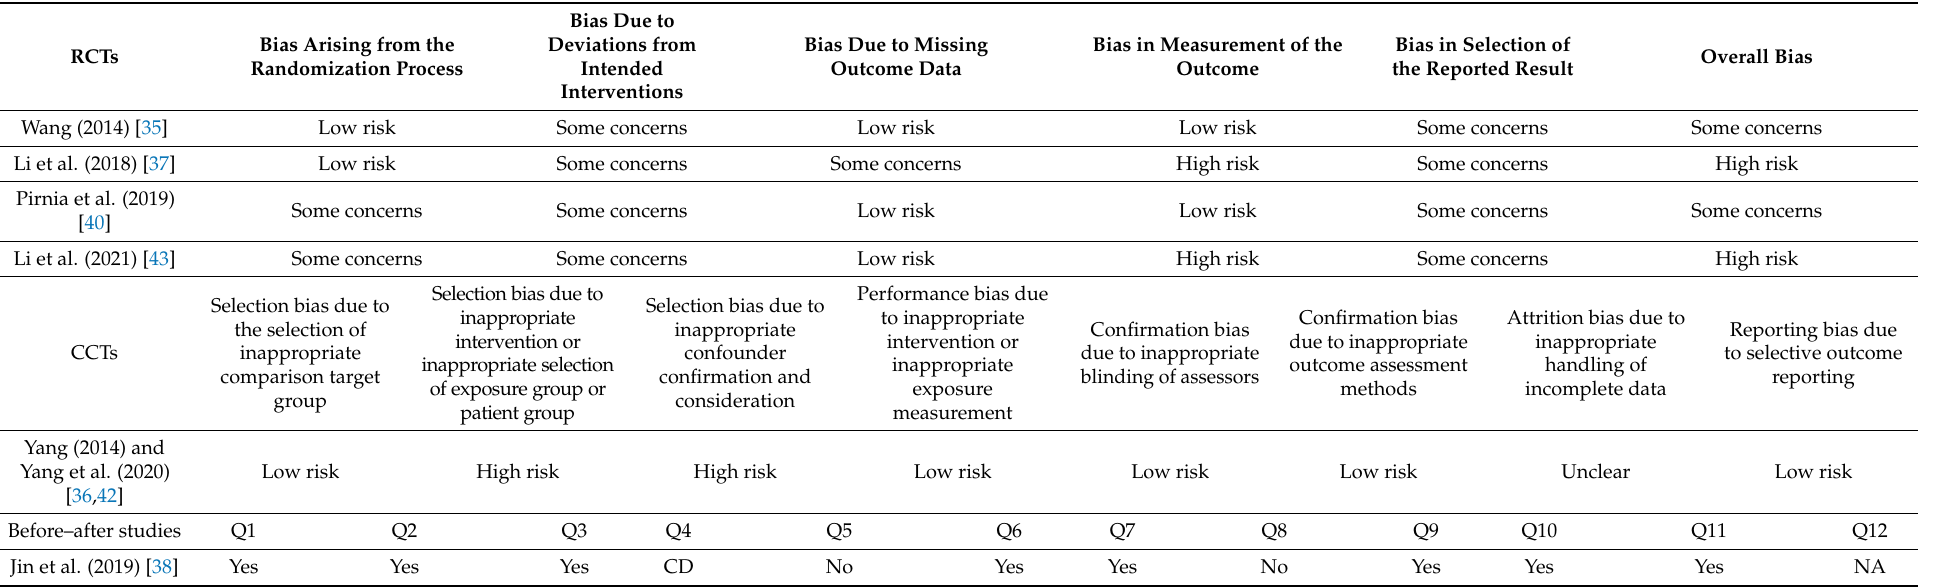
Table 2. Methodological quality of the included